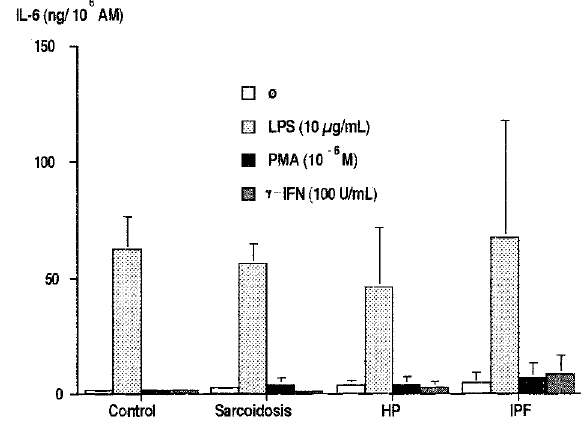
FIG. 4. Interleukin-6 secretion in the different experimental groups. Study of the effect of different stimuli on IL-6 secretion by AMs revealed statistically significant differences (Wilcoxon test, P =0.001 for LPS and P =0.008 for PMA). No significant differences were found between basal and inter- feron-induced secretion. Comparison of LPS-induced and PMA-induced secretion revealed statistically significant dif- ferences (Wilcoxon test, P =0.003). Comparison among the different groups study did not disclose significant differences under either basal or stimulated conditions. Definition of